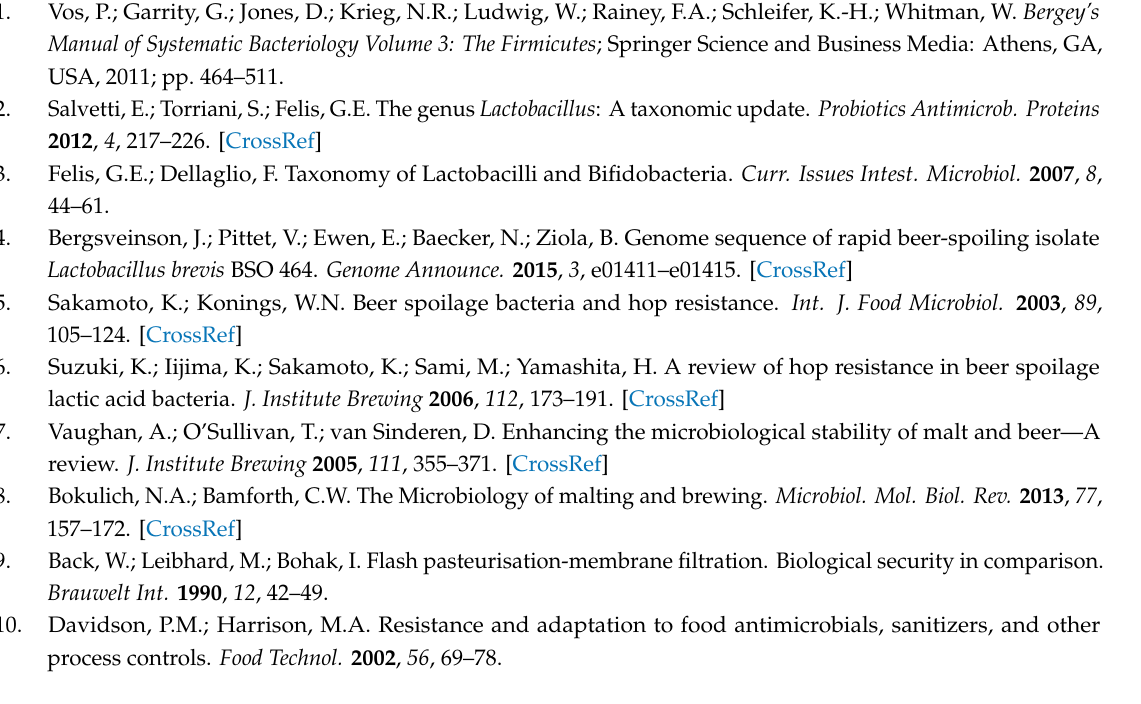
Figure S1: Growth of ( A ) Lb. brevis beer-spoiling strain UCCLBBS124, ( B ) Lb. brevis strain UCCLB521 and ( C ) Lb. brevis strain SA-C12 when challenged with lytic phages (MOI = 1 when the culture reached an OD 600nm of 0.2). A culture of the bacterial strain where no phage was added was used as a